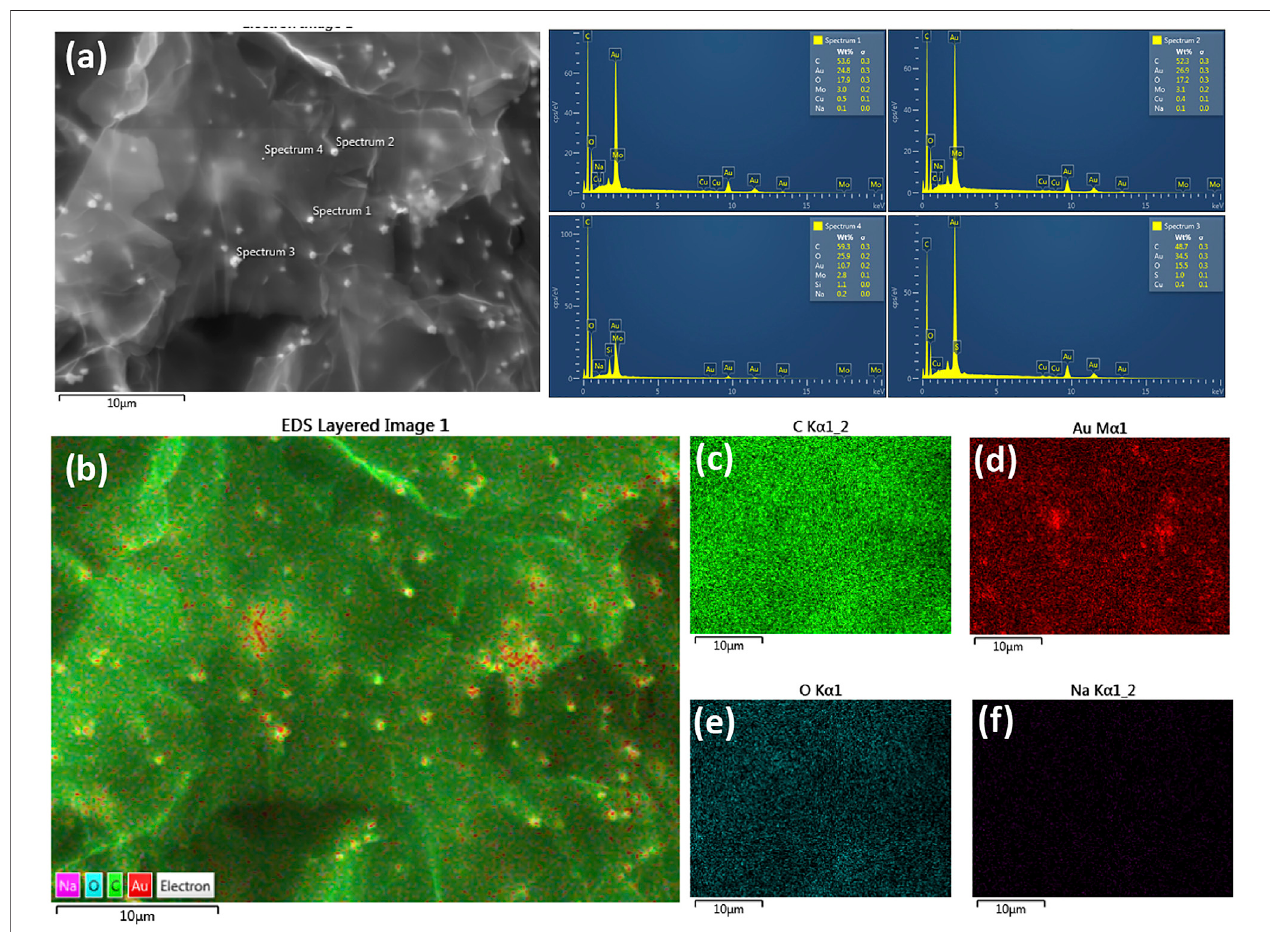
FIGURE 4 | (A) EDXA spectra and (B – F) elemental mapping of the rGO- Au nanocomposite.